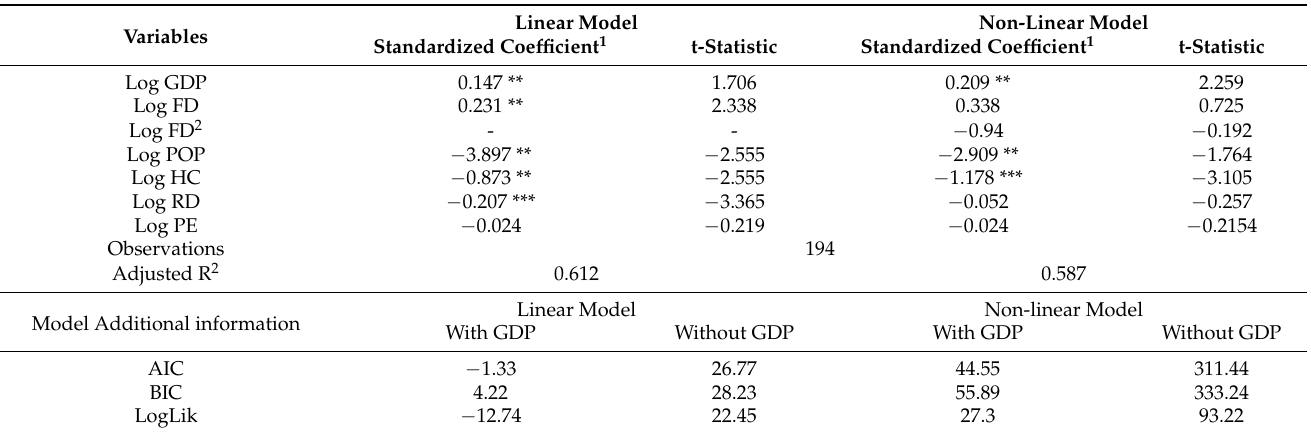
Table 10. Panel data-fixed effect regression results. Dependent variable: